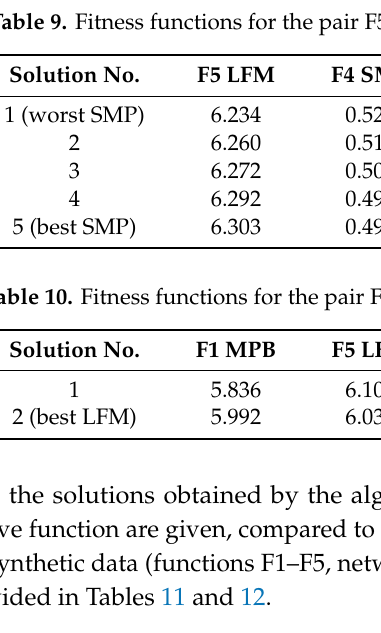
Table 11. Detailed results for relevant solutions obtained by the algorithm—objective functions.